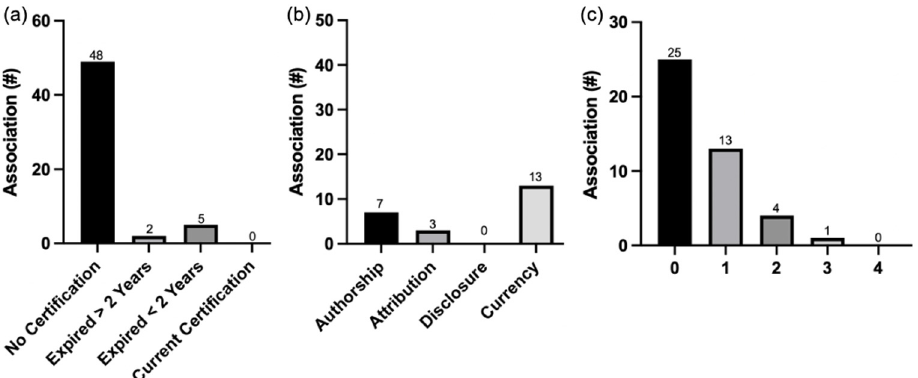
Figure 2. The quality analyses using the Health On the Net (HON) Foundation Code of Conduct (HONCode) and JAMA benchmarks. ( a ) The number of associations that either have never had a HONCode certification, have a certification that expired over two years ago, have a certification that expired under two years ago, or have a current certification. ( b ) The number of associations, out of 43 associations, that display each of the individual JAMA benchmarks, including authorship, attrib- ution, disclosure, and currency. ( c ) The number off associations that display zero, one, two, three, or all four of the JAMA benchmarks.